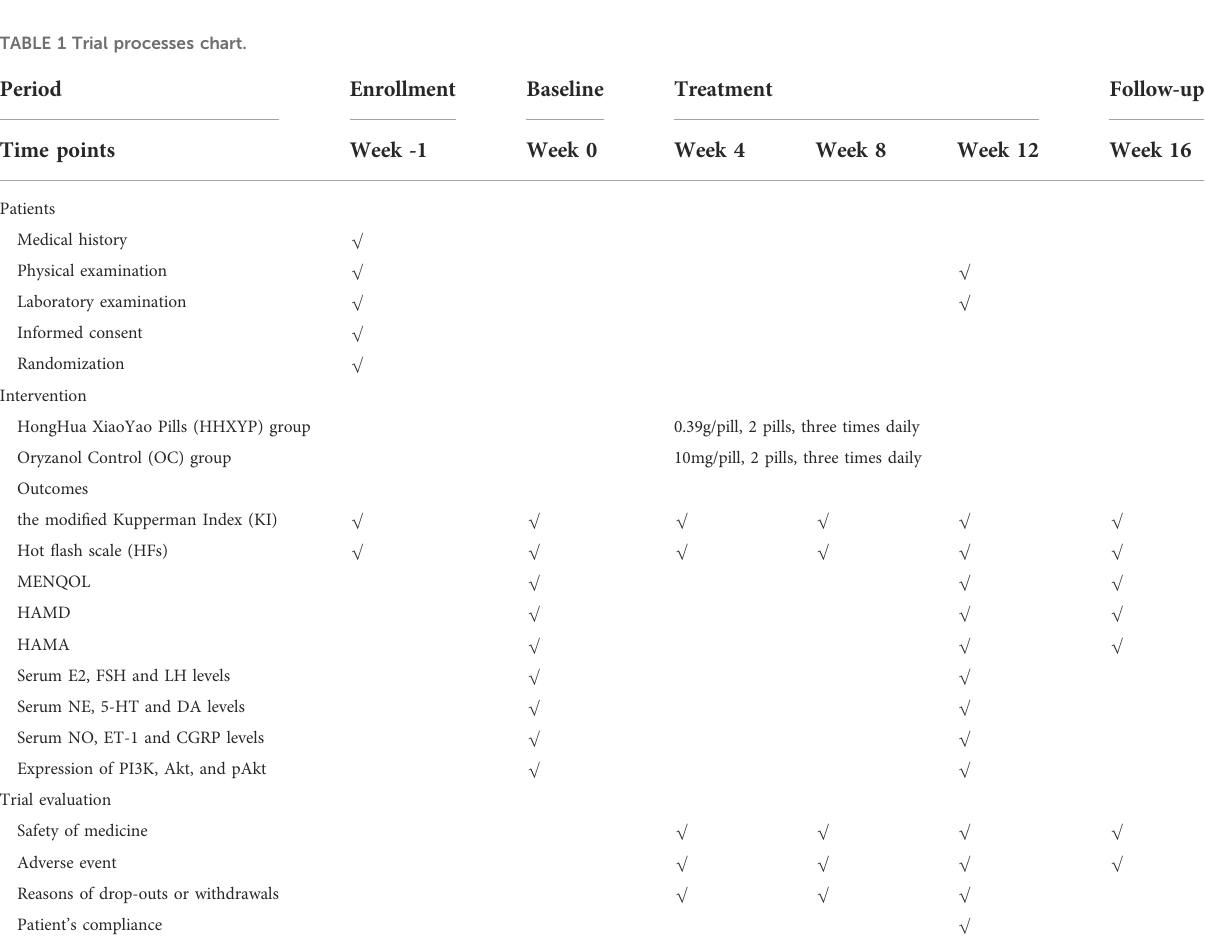
TABLE 1 Trial processes